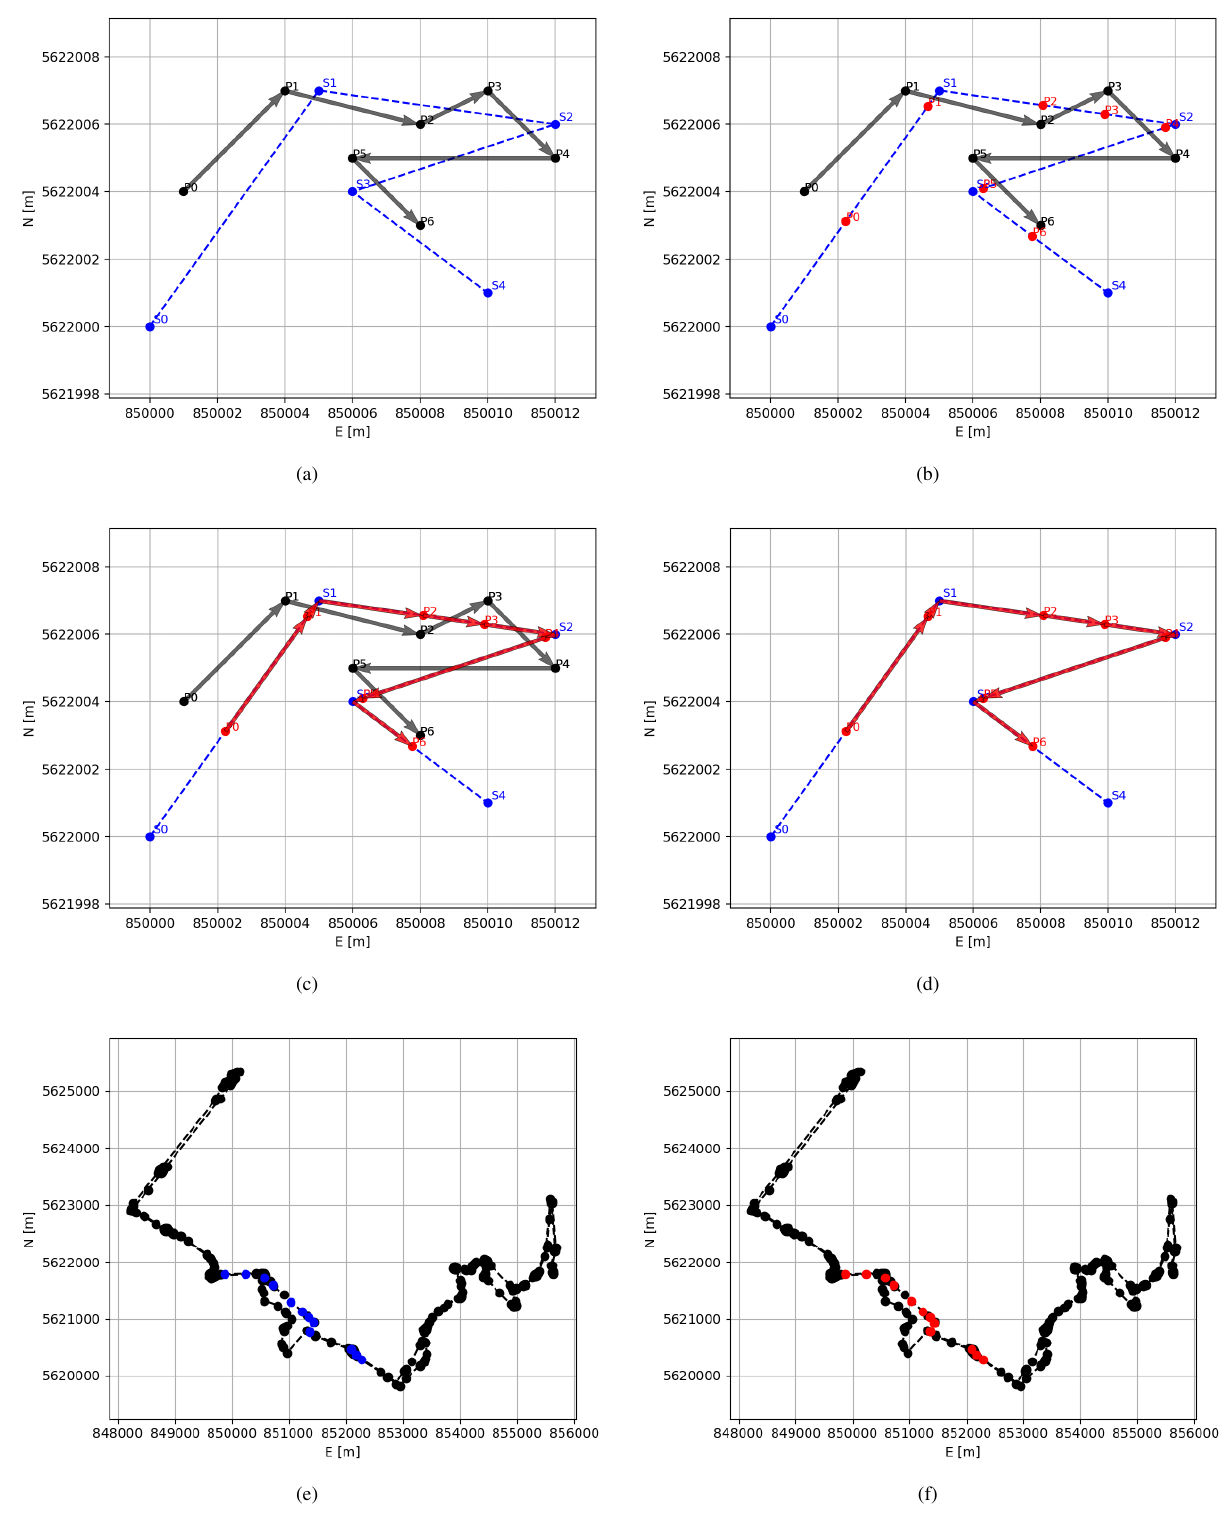
Figure 14. (a) The projection of FCD points within the line network: the black dots represent the original FCD and the black arrows the computed velocities; in blue the stops of the line route. (b) The red dots are the projection of the FCD within the line route. (c) and (d) the red arrows are the projected velocities. (e) Original FCD for vehicle 363 in service for line 39. (f) Projected FCD for vehicle 363 in service for line